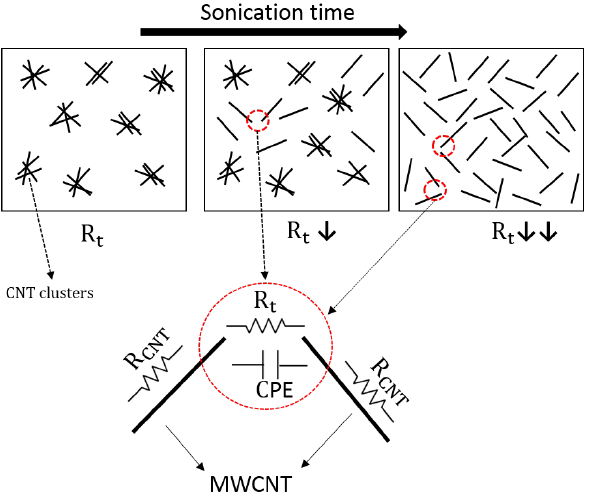
Figure 12. Influence of tunneling resistance due to sonication of fMWCNT dispersion The impedance response has been fitted to an equivalent circuit model and the corre- sponding circuit parameters were extracted to determine the tunneling resistance. Figure 13 shows the tunnelling resistance of fMWCNT in various solvents. It can be seen that the tunnelling resistance decreases with the increases in all sonication time for fMWCNT in all solvents. The highest value is 6.323 k Ω for fMWCNT/Toluene dispersion at 15 min of sonication and the lowest value is 1.083 k Ω for fMWCNT/Water dispersion at 120 min of sonication. Compared to the fMWCNT dispersion based on high polar solvent such as water, the tunnelling resistance is reduced from 73.03% to 73.35% in fMWCNT dispersion in a low polar solvent such as toluene. This means more fMWCNT is dispersed, and the distance between them is reduced. At all sonication time, the tunnelling resistance (R t ) values of the modified electrodes based fMWCNT dispersion in a solvent which follows the order: Water < ethanol < 2-propanol < toluene.